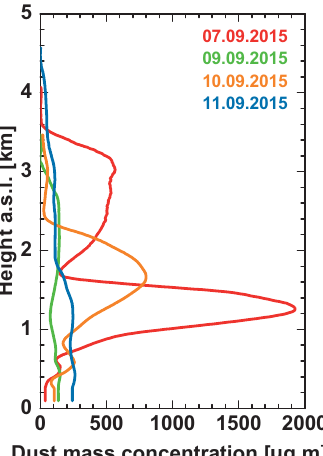
Figure 10. Lidar-derived mean dust mass concentrations for the evening periods (see Fig. 9) of 7 September (19:00– 20:00UTC), 9 September (19:00–21:28UTC), 10 September (17:16–20:25UTC), and 11 September (17:11–21:25UTC). The overall uncertainty in the retrieval of the dust mass concentration is of the order of